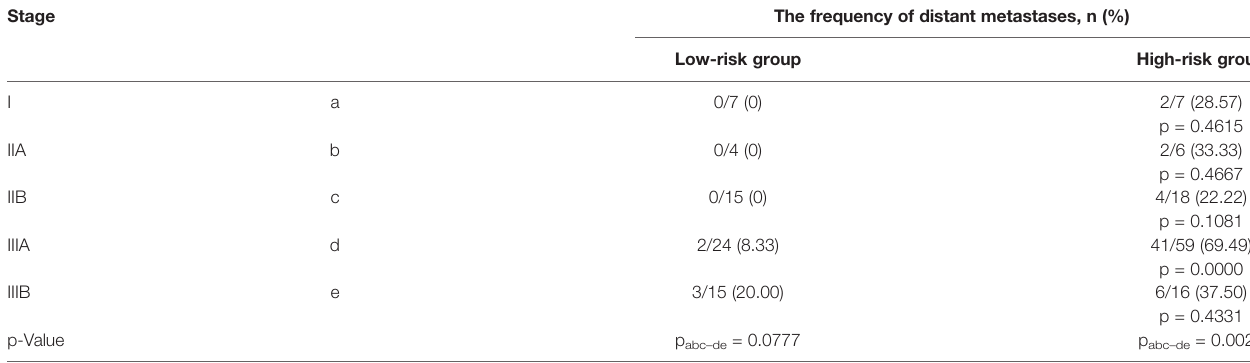
TABLE 4 | The frequency of distant metastases in groups of high and low risk of metastasis, depending on the cancer in NSCLC patients.